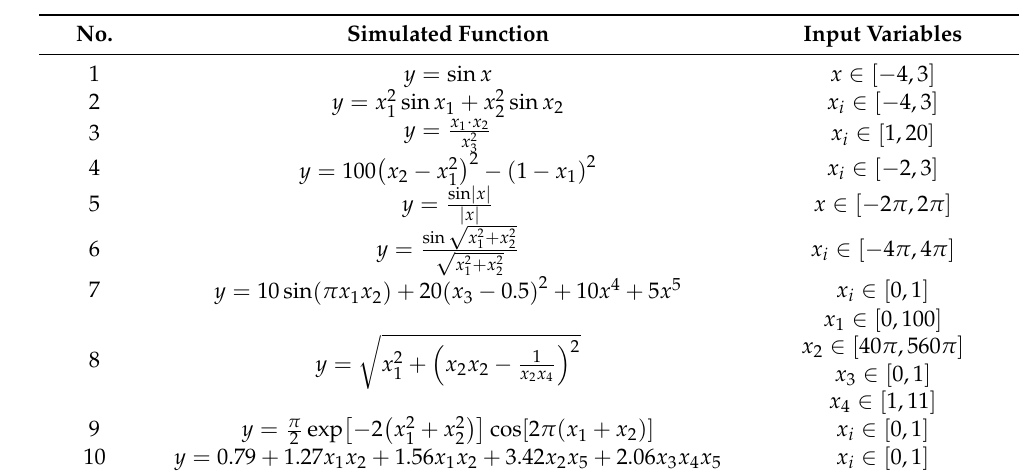
Table 1. Set of test